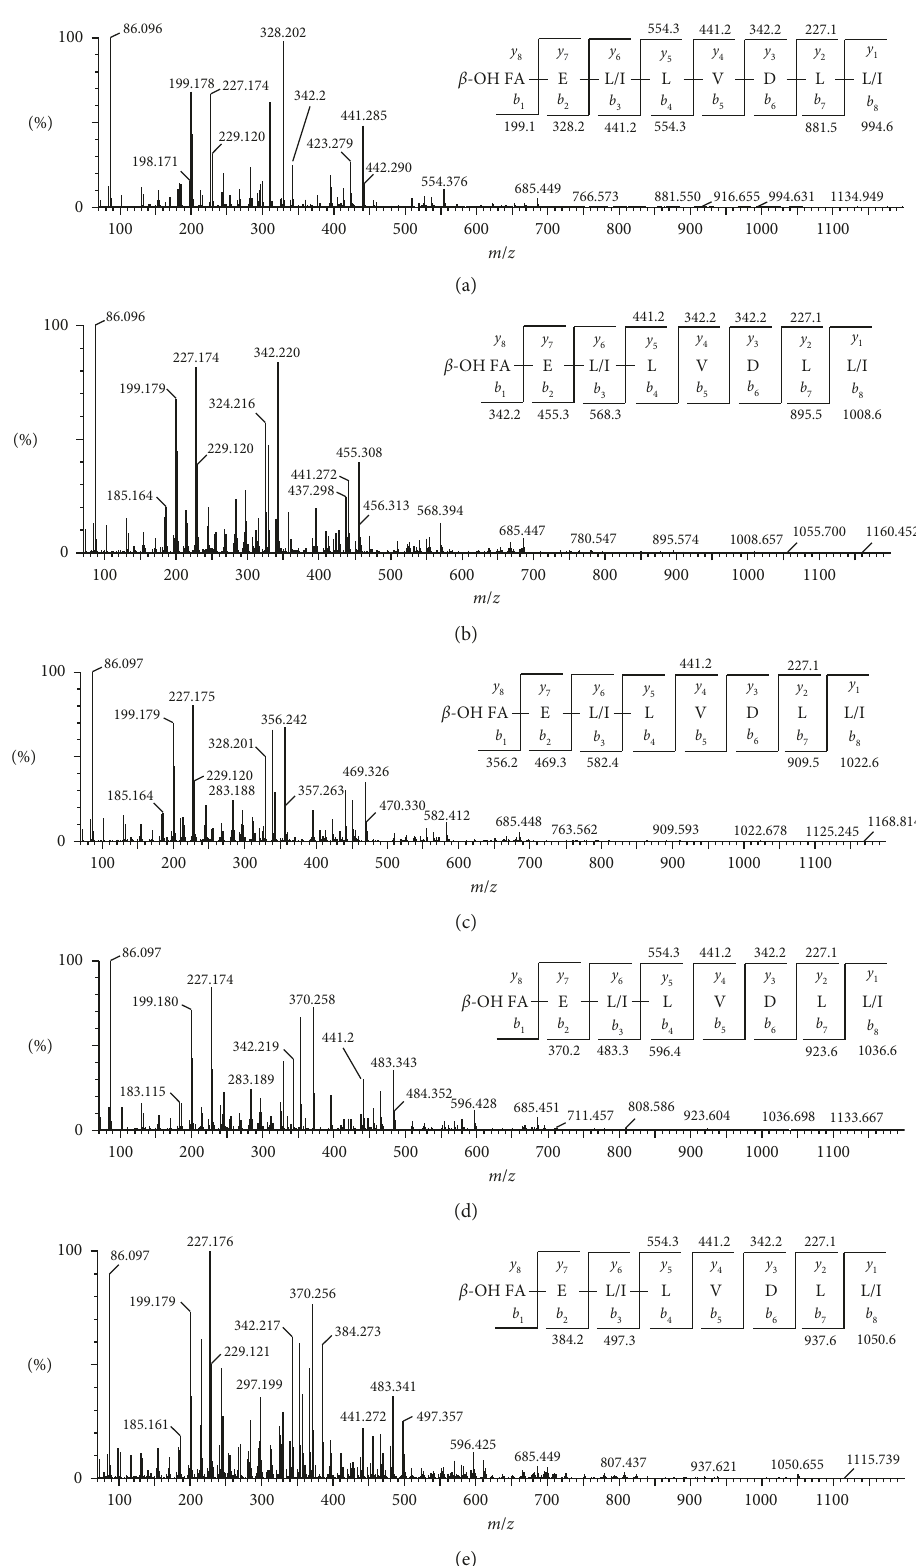
Figure 2: ESI-MS/MS spectra of [M +H] + ions at m / z 994.62 (a), 1008.65 (b), 1022.67 (c), 1036.69 (d), and 1050.71 (e). FA, fatty